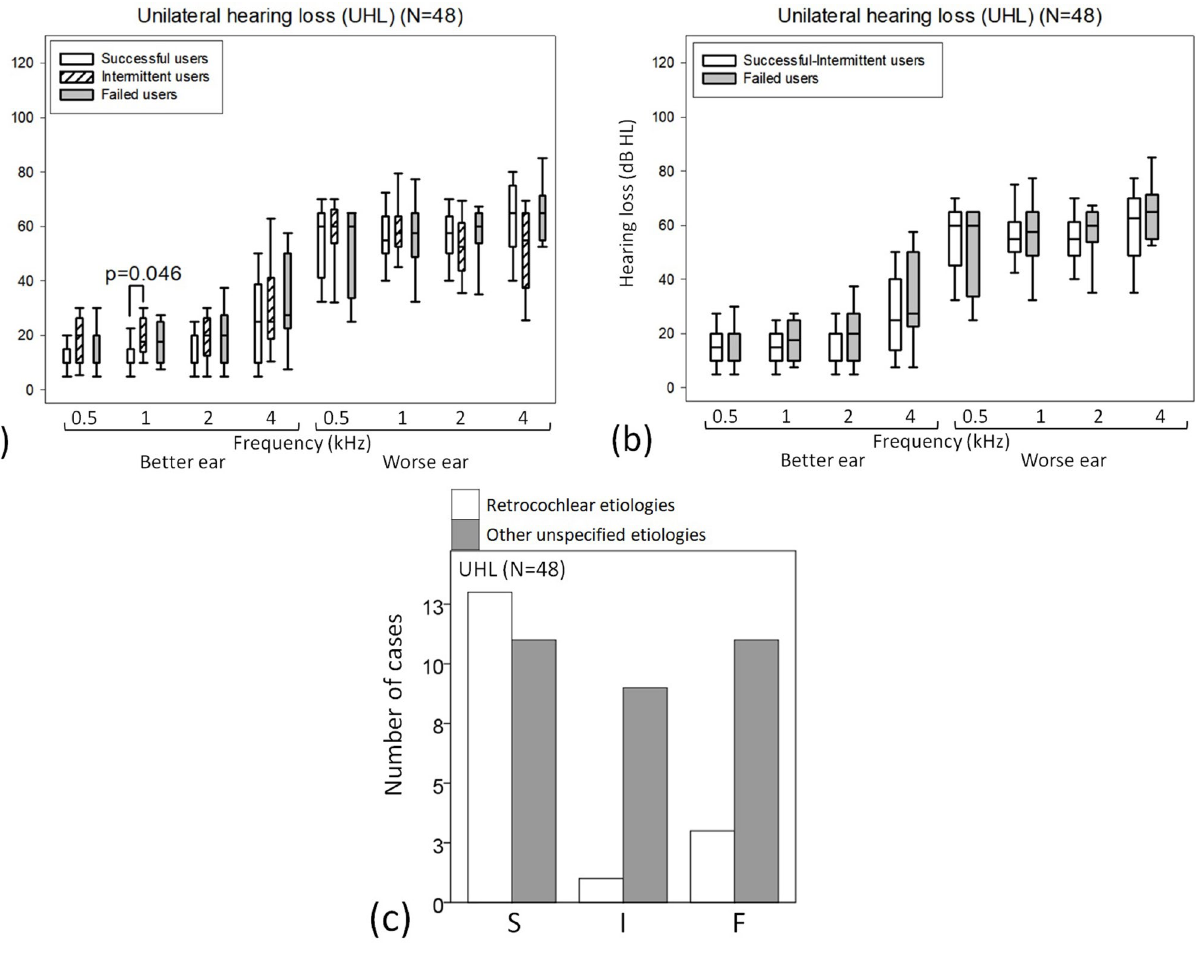
Figure 2. ( a – c ) In the UHL subgroup (n = 48), box plots of differences in the hearing thresholds according to ( a ) three and ( b ) two outcomes. Comparison by the etiology of hearing loss according to ( c ) three outcomes.